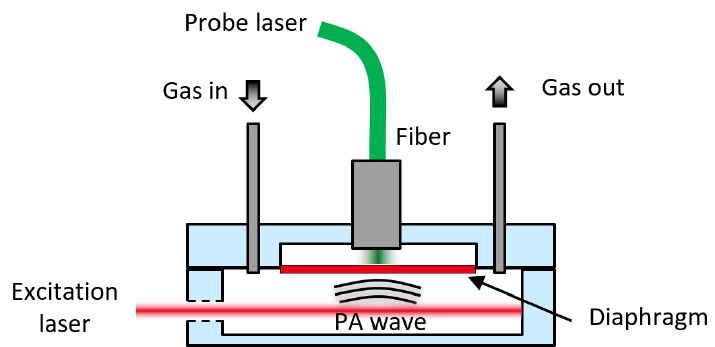
Figure 1. Diagram (not to scale) of the all-optical multipass PA trace gas sensor with the PA cell (lower volume), the transducer part with the optical cavity (upper volume), the probe and excitation laser (respectively green and red light beam).